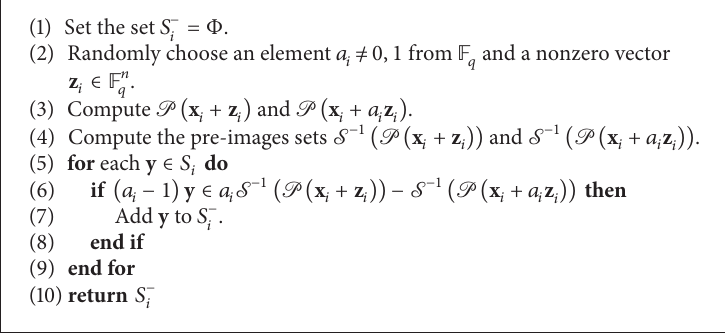
Algorithm 3: Differential sieve: DifSieve ( F 𝑞 , S , P , x 𝑖 ,𝑆 𝑖 )